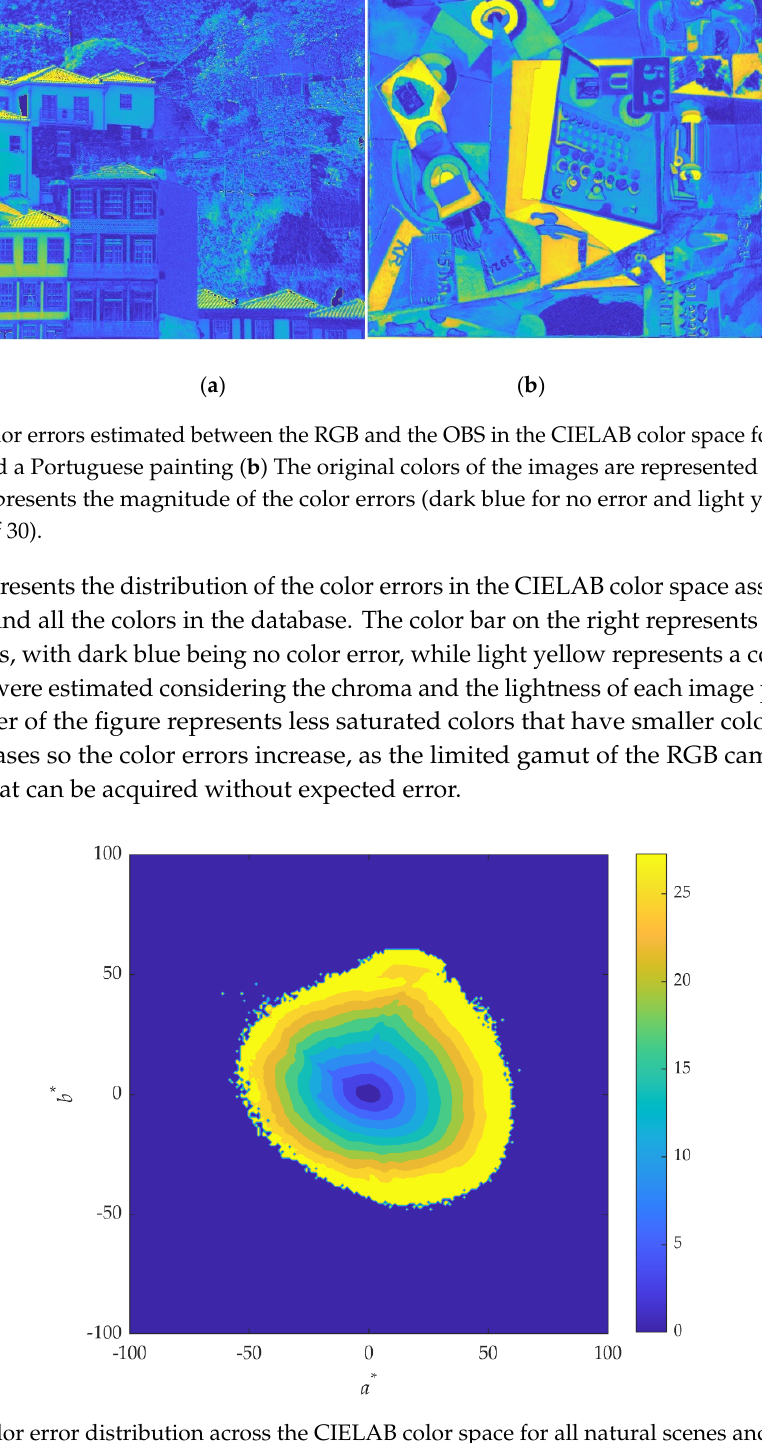
Figure 7. Color error distribution across the CIELAB color space for all natural scenes and paintings and CIE D65 illuminant. The right color bar represents the magnitude of the color errors.